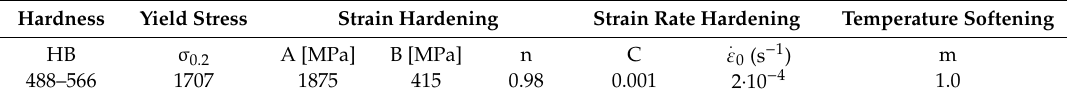
Table 2. Material properties for Armstal 500 steel for the MAT_MODIFIED_JOHNSON_COOK material model.